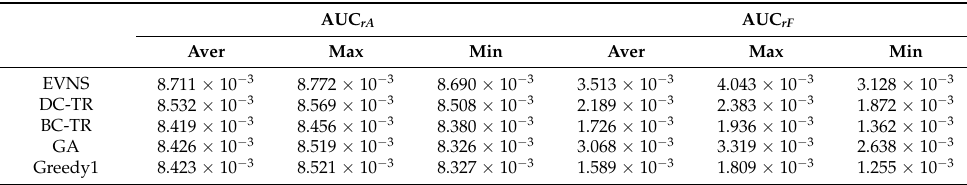
Figure 11. Comparison of different optimal recovery supplier selection methods under target disruption of 3000 suppliers: ( a ) r A recovery curves; ( b ) r F recovery curves. Table 3. AUC rA and AUC rF comparison of different methods under the target disruption of 3000